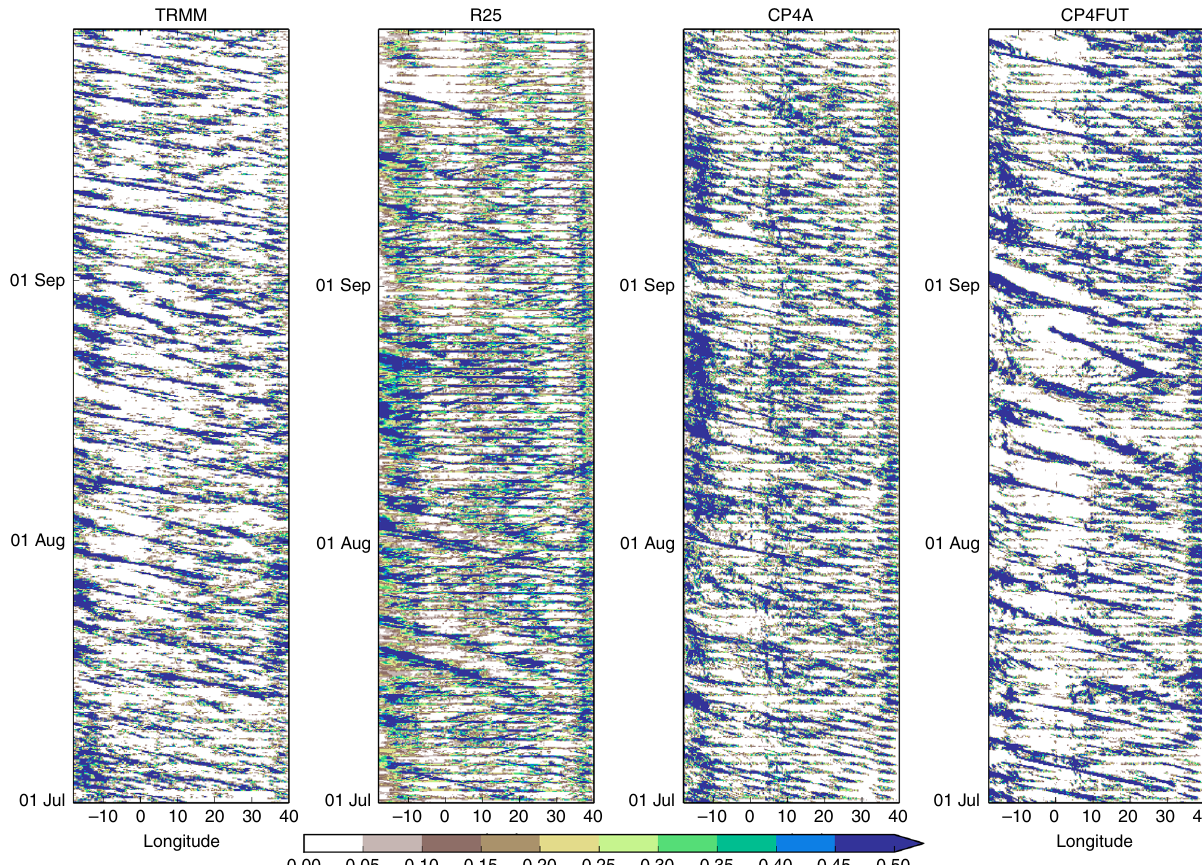
Fig. 9 Hovmöller plots of 3-hourly precipitation. Precipitation (mm h − 1 ) averaged over the latitude band 5 – 15° N for July – August – September (JAS) 2001 for TRMM, R25 and CP4A and for the equivalent season in the CP4A future